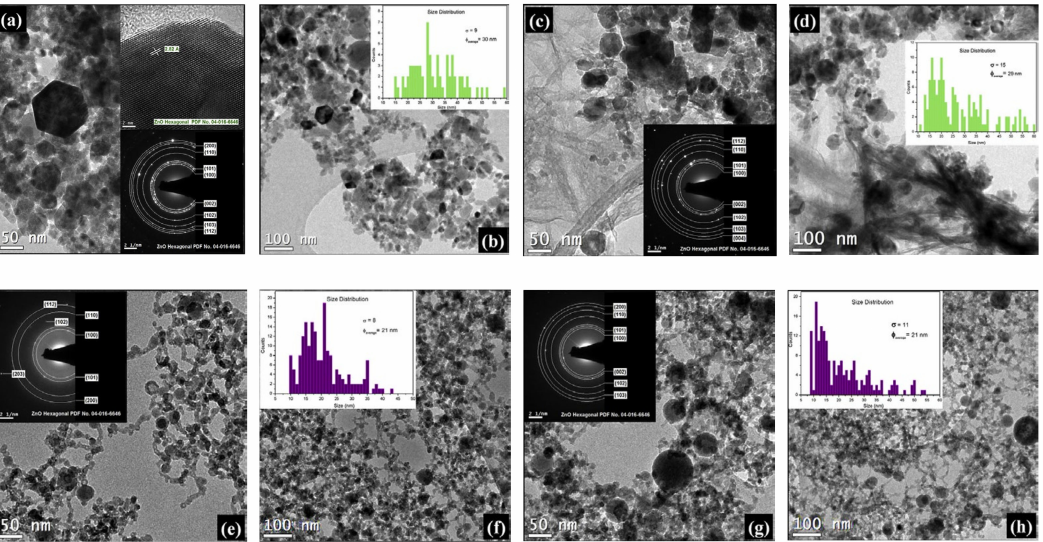
Figure 8. Transmission electron microscopy images of the zinc nanoparticles produced at a laser wavelength of 532 nm in distilled water ( a – d ) at 70 ◦ C and ( e – h ) 90 ◦ C with fluence values of ( a , b , e , f ) 6.0 J/cm 2 and ( c , d , g , h ) 8.6 J/cm 2 . Inset images illustrate ( b , d , f , h ) the size distribution, ( a , c , e , g ) the selected area diffraction (SAED) patterns, and ( a ) the high-resolution transmission electron microscopy image. Adapted with permission from Ref. [114]. Copyright 2015, Elsevier